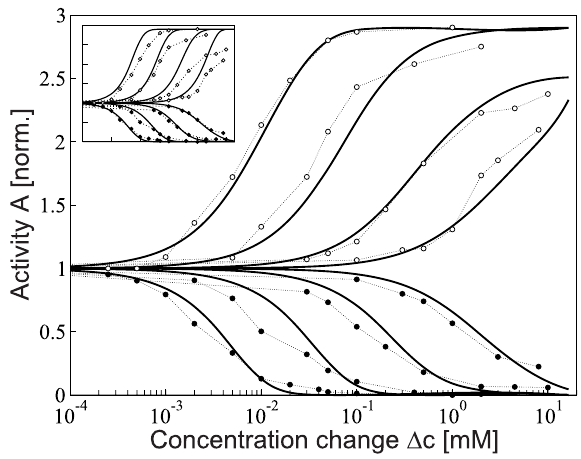
Figure 1. Response of wild-type cells to step changes D c of MeAsp concentration at different ambient concentrations. Dose-response curves: Symbols represent averaged response from FRET data (WT1) after adaptation to ambient concentrations 0, 0.1, 0.5 and 2 mM as measured by Sourjik and Berg [23] (filled and open circles correspond to response to addition and removal of attractant, respectively). Solid lines represent the dynamic MWC model of mixed Tar/Tsr-receptor complexes including ligand rise (addition) and fall (removal), as well as adaptation (receptor methylation) dynamics. ( Inset ) Dose-response curves for MWC model without adaptation dynamics (lines). FRET and receptor complex activities were normalized by adapted pre-stimulus values at each ambient concentration. Squared errors between model and experimental data for the four dose- response curves shown are 0.64 (dynamic MWC model) and 3.95 (static MWC model), respectively. For comparison, fitting to eight addition and , K off , as well as a linear removal dose-response curves using K on a ( s ) a ( s ) function N c 0 ð Þ as fitting parameters, yields squared errors 0.83 (dynamic MWC model) and 2.09 (static MWC model), see Supplemen- tary Text S1.